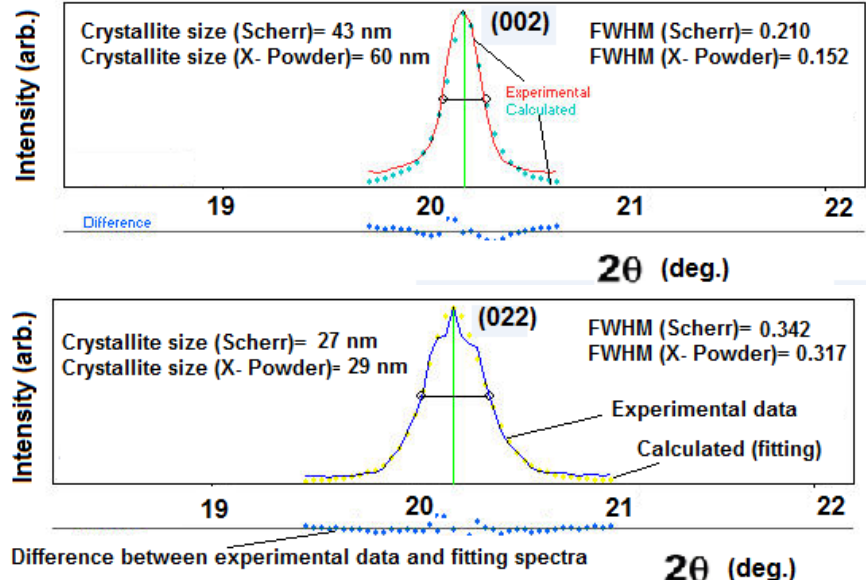
Fig. 4. The size of (up) (002) WO crystallite phase is 43 nm (Scherer) and 60 nm (X- Powder) and (down) (022) WO 3 is 27 nm (Scherer) and 29 nm (X- Powder). FWHM is β in Scherer